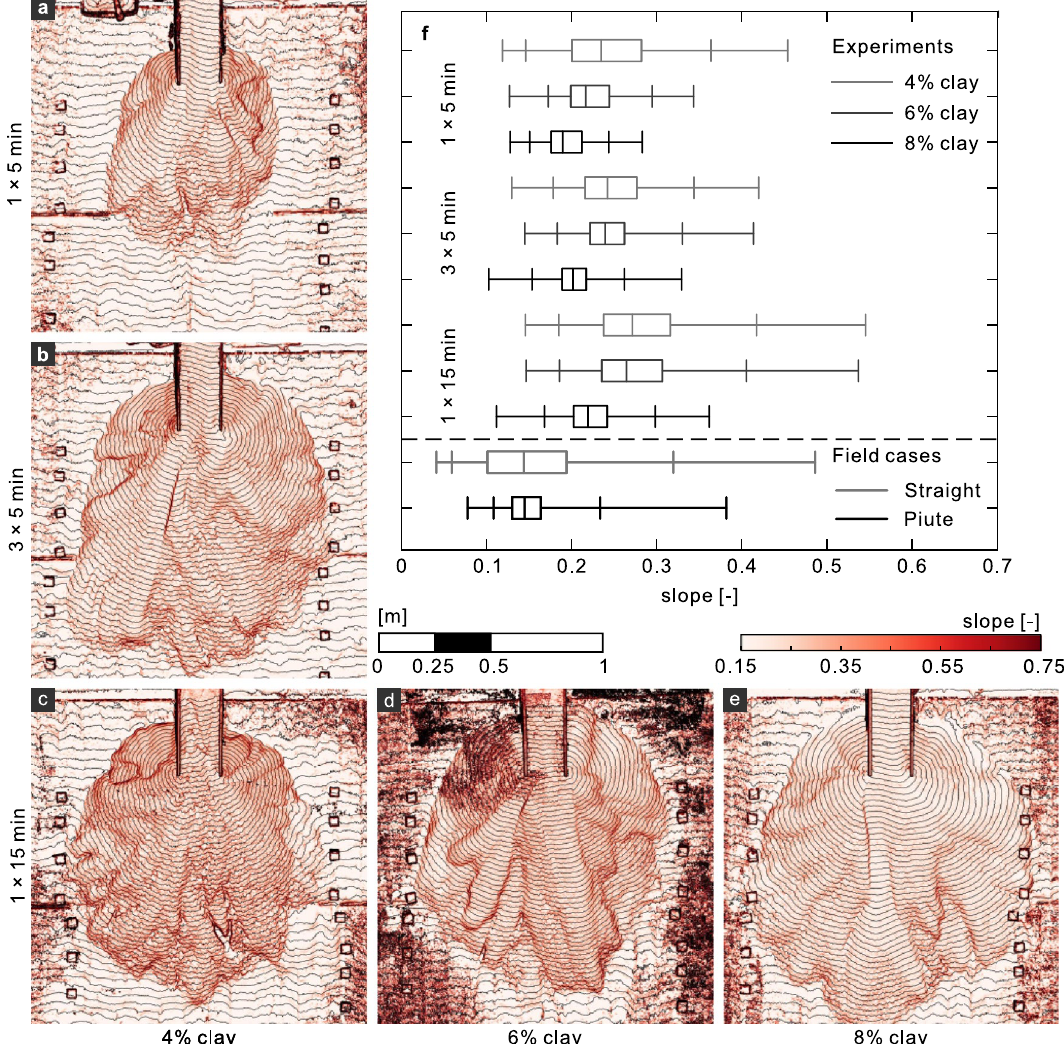
Figure 3. ( a–e ) Elevation contours and slope maps of experimental fans. Contour line spacing represents 5 mm elevation changes. ( a–c ) shows results for runs of constant clay content performed for different discharge timescales: ( a ) one 5-min flow, ( b ) three successive 5-minute flows ( a ) one 15-min continuous flow. ( c–e ) results for runs of one 15-min flow and clay contents of ( c ) 4%, ( d ) 6%, and ( e ) 8%. (More in Supplementary Figs. 3, 4). ( f ) Boxplot for the slope distribution of the fan surface in 9 representative experiments and the 2 field cases we studied. The boxplot displays the dataset based on the 1st, 5th, 25th, 50th, 75th, 95th, and 99th percentiles (Supplementary Table